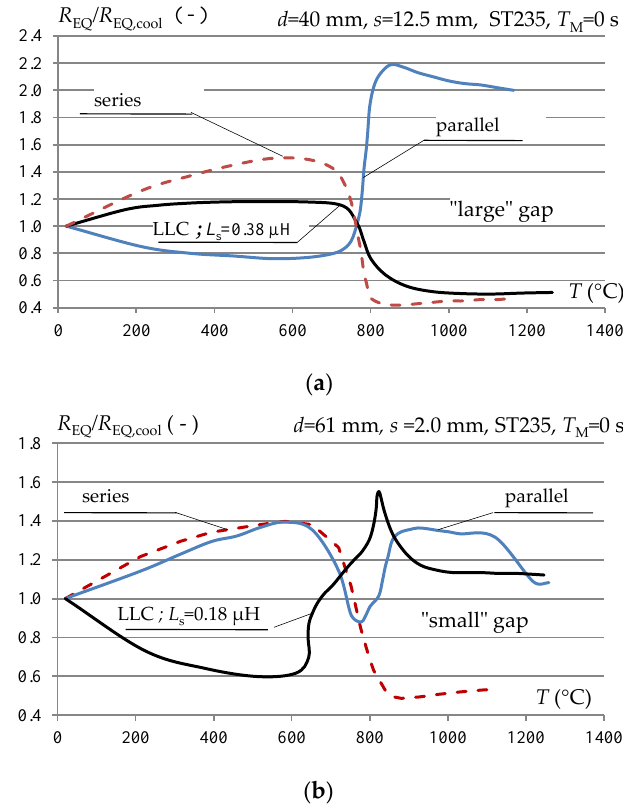
Figure 7. Comparison of relative changes in resonance equivalent resistance of the load as a function of the charge surface temperature during heating by an inverter with different types of resonance system: ( a ) “large” gap and ( b ) “small” inductor–charge gap.